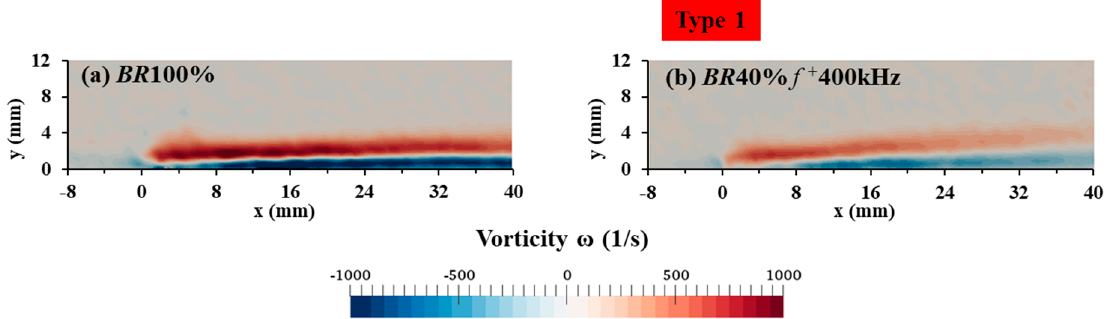
Figure 8. Vorticity-field contours for the case of ( a ) continuous operation with F = 7.2 kHz and BR = 100% and ( b ) burst modulation with F = 7.2 kHz, BR = 40% and T on = 1 ms ( f + = 400 Hz).